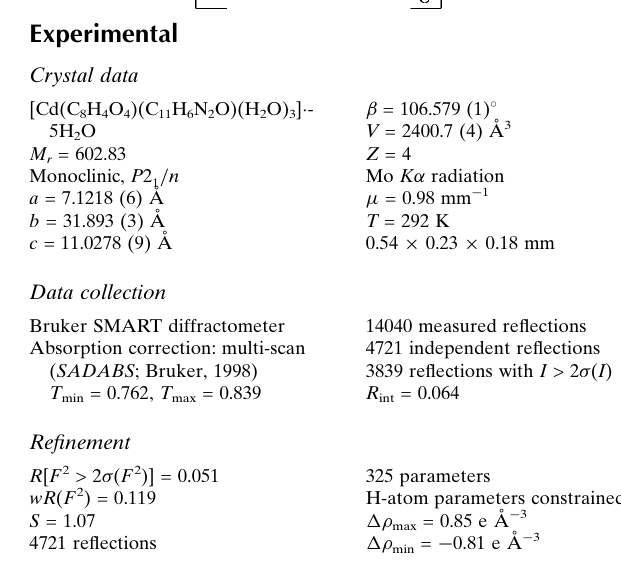
Key indicators: single-crystal X-ray study; T = 292 K; mean (cid:2) (C–C) = 0.006 A˚; disorder in main residue; R factor = 0.051; wR factor = 0.119; data-to-parameter ratio = 14.5.